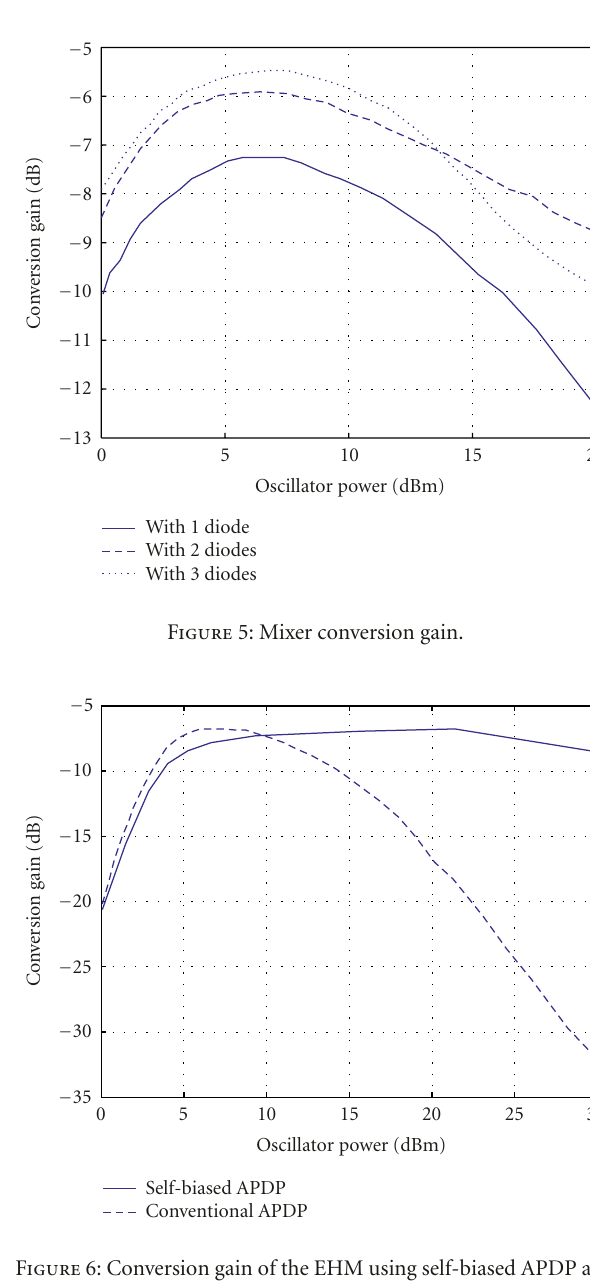
Figure 6: Conversion gain of the EHM using self-biased APDP and conventional